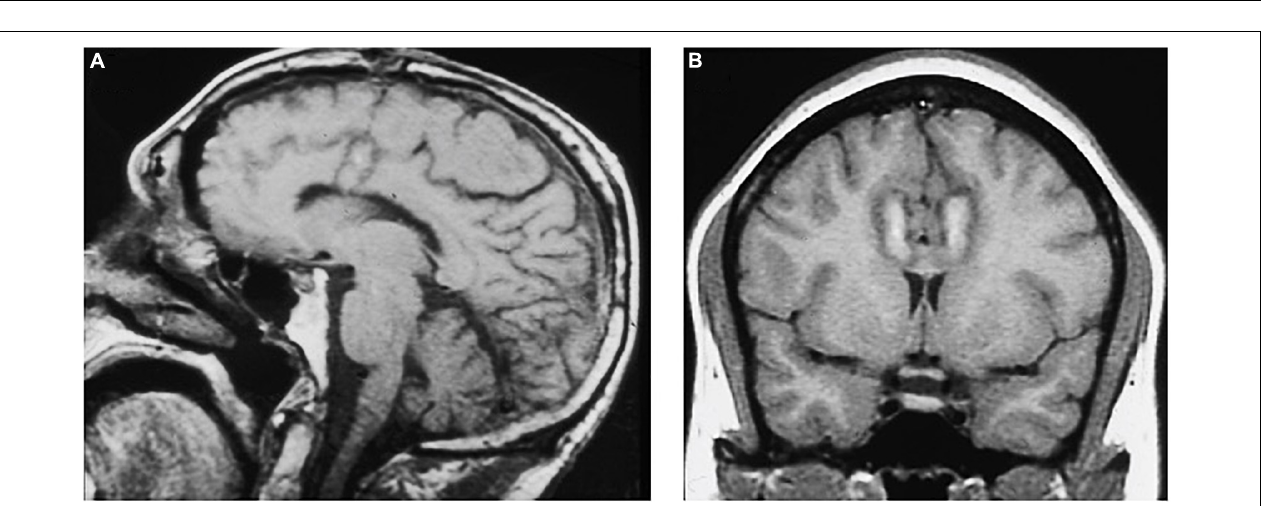
FIGURE 4 | MRI-guided cingulotomy. (A) Sagittal and (B) Coronal T1-weighted MRI of acute single lesion